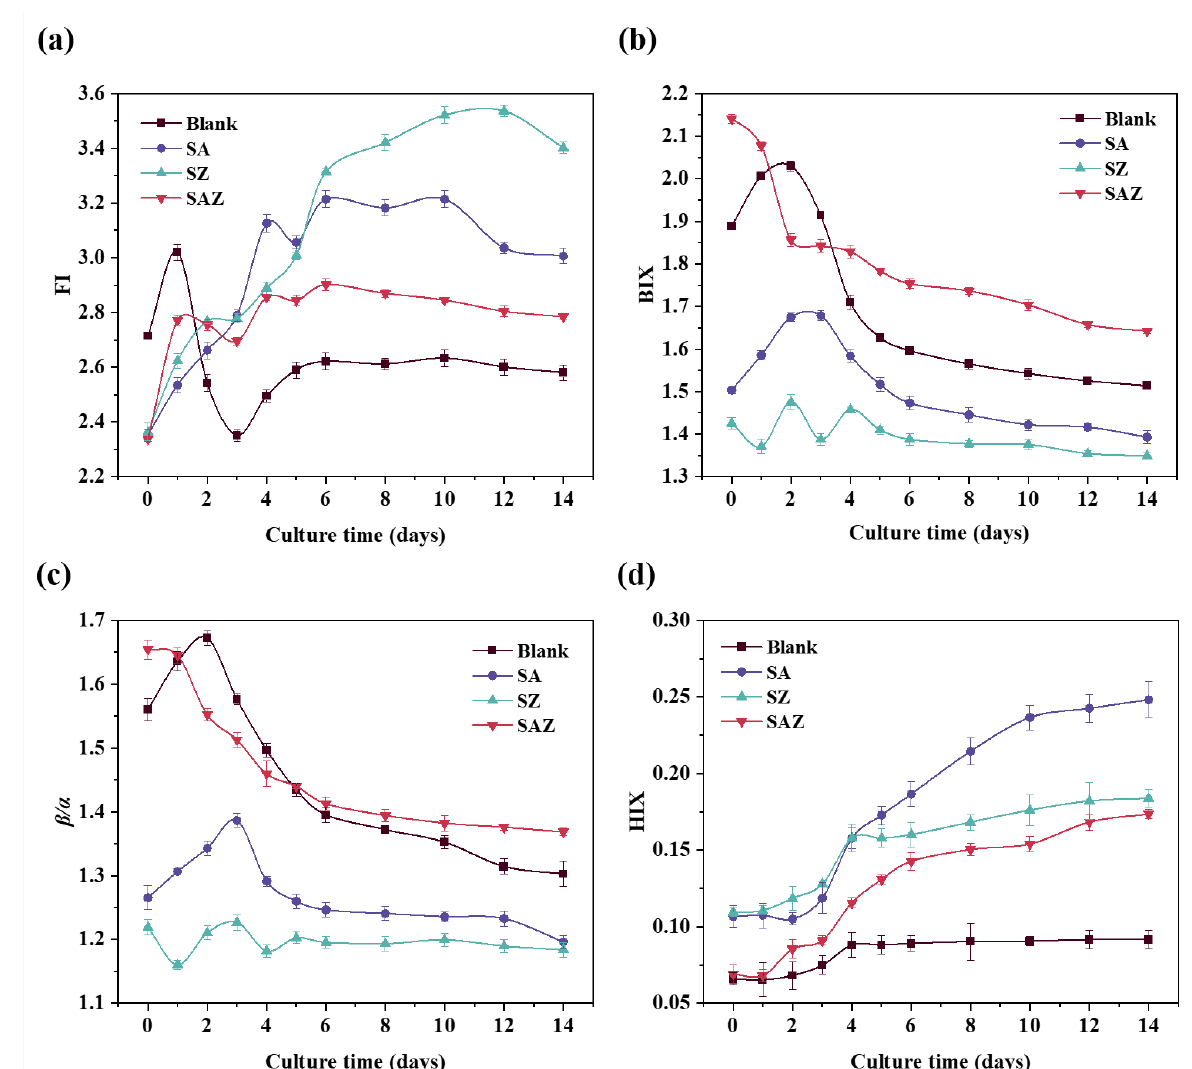
Figure 4. Changes in fluorescence indices of S.dohrnii of different treatments during the culture time. ( a – d ) are represented as FI, BIX, β / α , and HIX, respectively. Error bars represent the standard error for duplicate cultures. Note error bars are smaller than the symbol sizes in some cases.